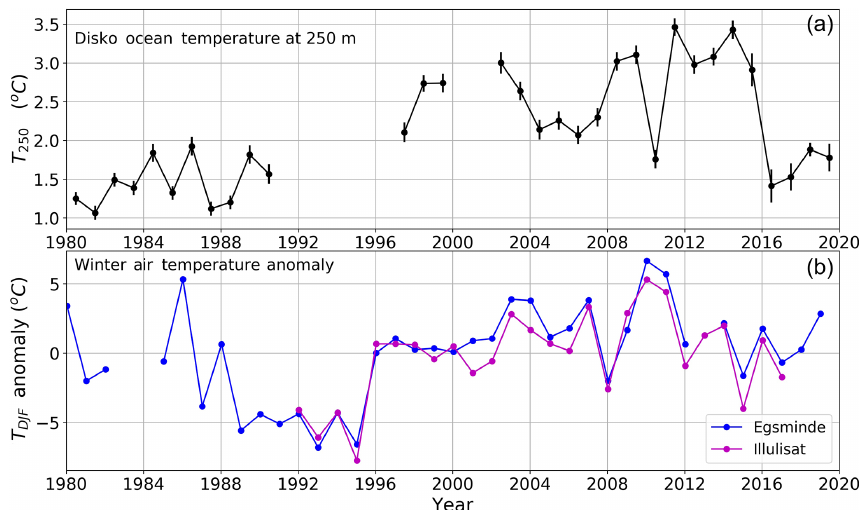
Figure 6. (a) Ocean temperatures at 250m depth in Disko Bay (all available casts in the region: 68.6 ◦ < latitude < 69.4 ◦ , − 54 ◦ < longitude < 52 ◦ ), which is based on a similar figure by Khazendar et al. (2019). Small differences with their results exist based on the sampling region and the averaging scheme. The ocean temperatures for 2015–2019 are extracted from the Ocean Melting Greenland data set (doi:10.5067/OMGEV-AXCTD) and for 1980–2014 are extracted from the International Council for the Exploration of the Sea Oceanography (http://www.ices.dk/marine-data/data-portals/Pages/ocean.aspx, last access: 16 August 2019) database. To obtain estimates representative of 250m depth, we averaged temperatures from 225 to 275m depth. The bars indicate uncertainty in the mean based on the number of points in the sampling region. To compute them, we take the mean intra-annual standard deviation averaged over the full record as the intrinsic uncertainty for a single point (i.e. how representative a point measurement is for the entire region). We then scale this value by 1/sqrt (number of points) to determine the plotted bar for each annual mean. (b) Winter 2m air temperature (DJF) anomalies relative to the mean for the period from weather stations at Egsminde and Illulisat (GISTEMP Team 2019,